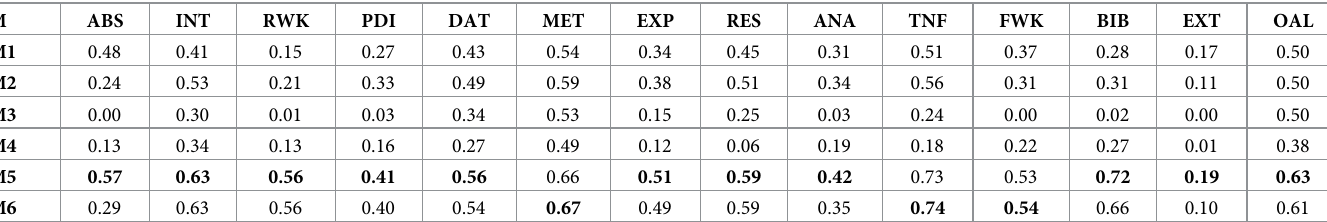
Table 5. Label-wise F1 scores (micro-averaged) for Task 1, M(1-6) ! Methods for evaluation, refer Table